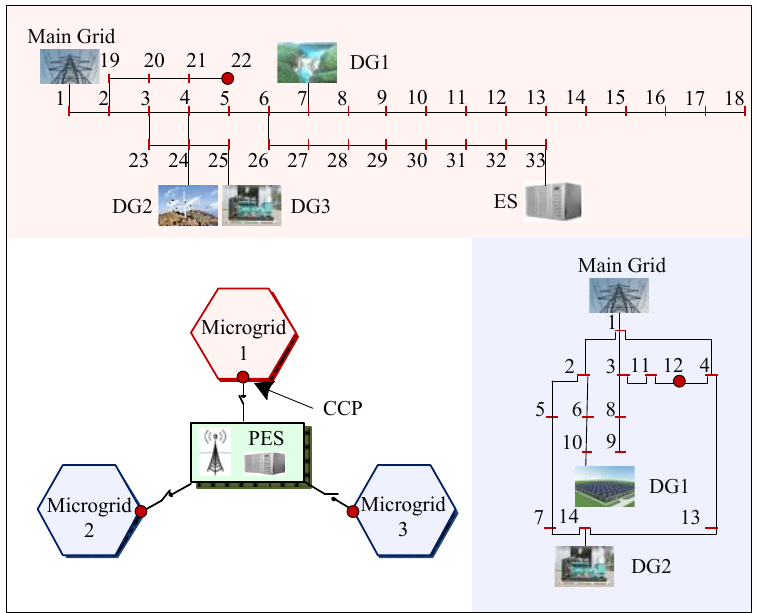
Figure 3. Schematic diagram of the reference system. Microgrid 1 is a modified IEEE 33-bus system [30] in which three DGs and one ES are added to format an autonomous grid. The CCP in microgrid 1 was set as node 22. Micro- grids 2 and 3 are both DC grids, which are transformed from the IEEE 14-bus system [31], and two DGs are added to both systems. The CCPs in microgrids 2 and 3 was set as as node 12. The branch conductance, node power, and node voltage of the three microgrids are shown in Tables 4 and 5. The parameters of all power sources in each microgrid are shown in Table